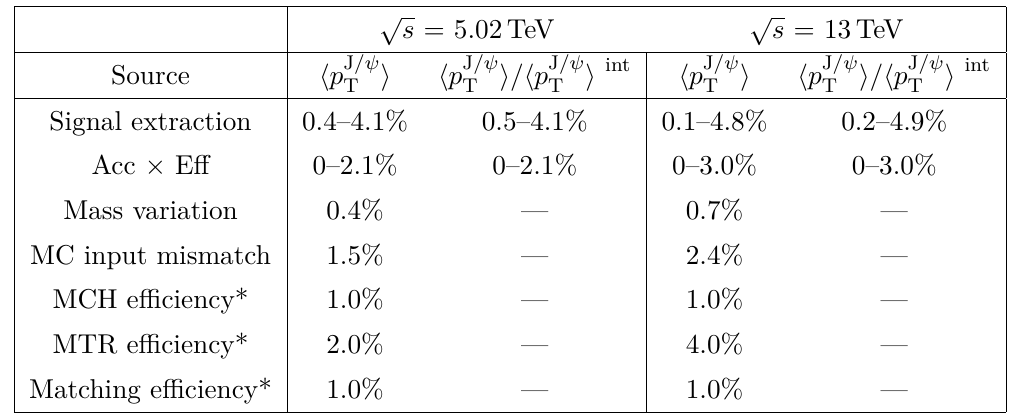
Table 5 . The summary of systematic uncertainties for relative h p J/ψ with (*) are taken from the ref.